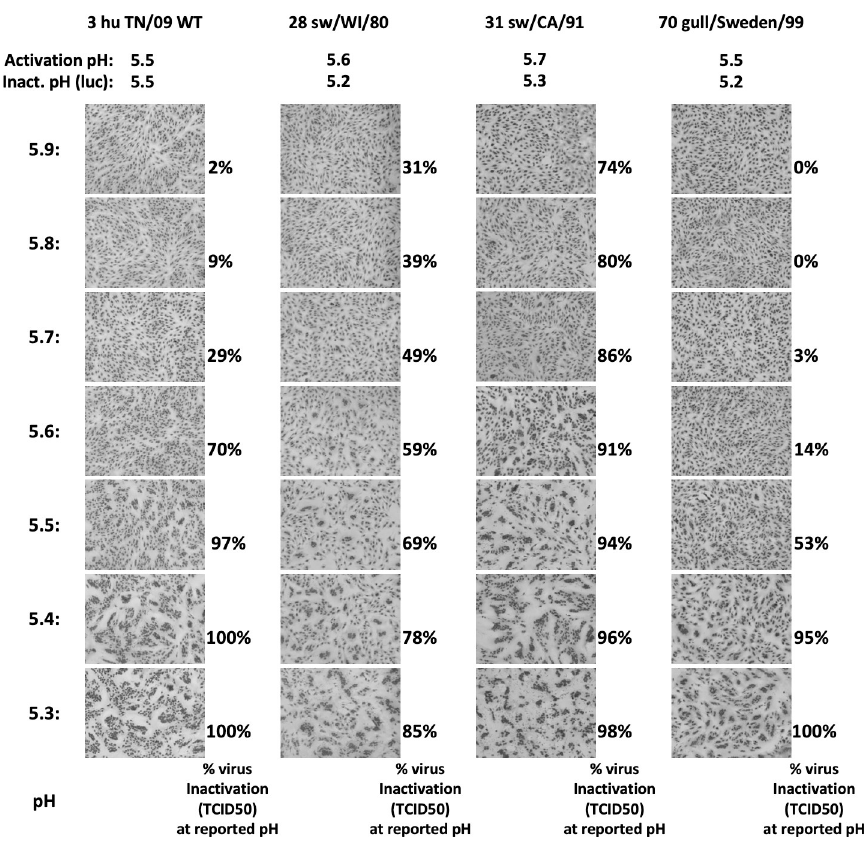
Fig 7. Comparison of percent virus inactivation and syncytia formation as a function of incubation pH. The percent of virus inactivation by TCID50 assay was calculated at pH values ranging from 5.3 to 5.9 at 0.1-unit increments. These values are displayed to the right of associated micrographs. HA activation pH values by syncytia assay and inactivation pH values by luciferase assay are provided at the top of each column for reference. The viruses are A/TN/09 WT, A/swine/Wisconsin/11/1980 (H1N1), A/swine/California/T9001707/1991 (H1N1), and A/black- headed gull/Sweden/5/1999 (H16N2).